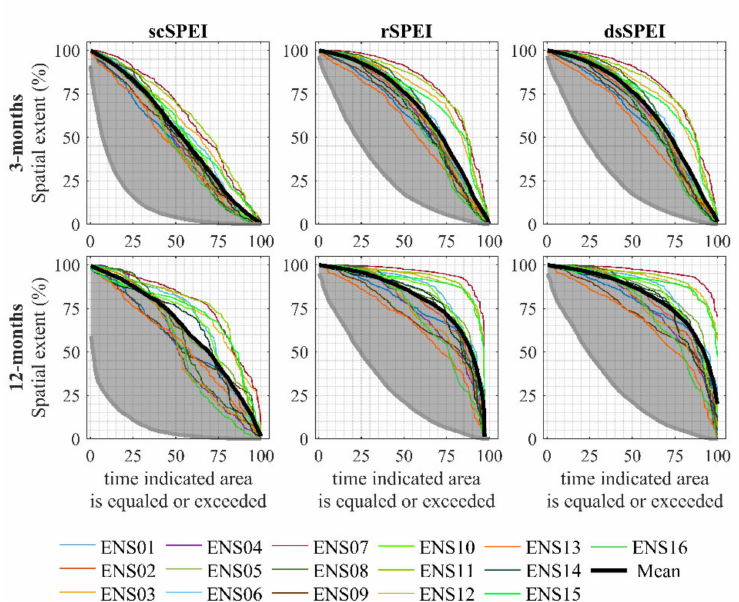
Figure 12. Areal extent-duration curves for all ensemble members and the ensemble mean for the far future. The gray line indicates the ensemble mean for the corresponding recent past period. The grey-shaded areas represent the difference between the ensemble mean of the different